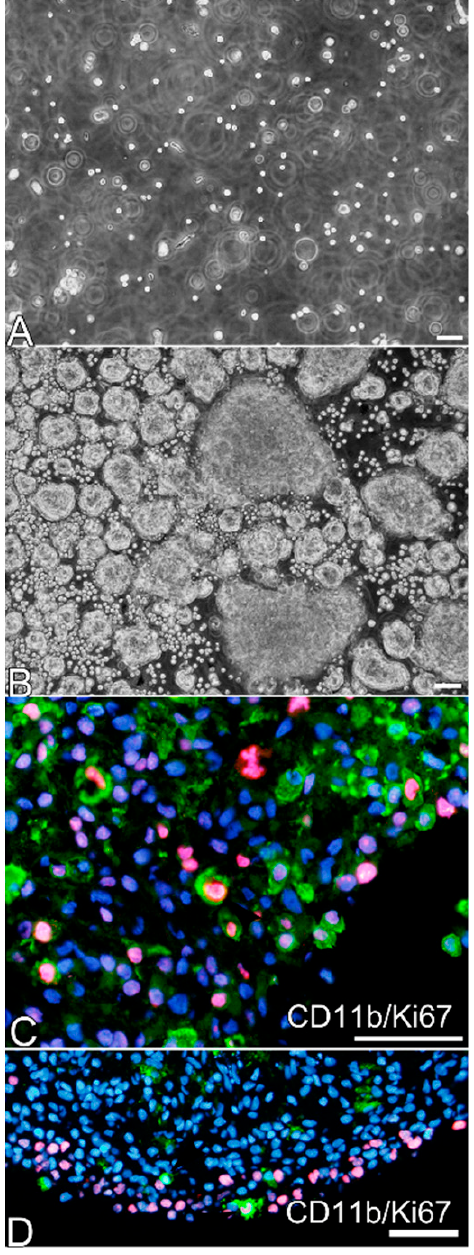
Figure 2. Dissociated and ex vivo cultures of peeled-off leptomeninges. ( A ) A phase contrast micrograph shows isolated cells suspended in E2-epidermal growth factor (EGF) that were obtained from peeled-off leptomeninges of neonatal rat brains by incubating with trypsin-ethylenediamine tetraacetic acid (EDTA). ( B ) After the dissociated cells were cultured for 4 days, they formed large aggregates. ( C ) After fixation, the aggregates shown in ( B ) were sectioned and immunostained with antibodies against CD11b (green), another marker of microglia/macrophages, and Ki67 (red). Many CD11b + amoeboid cells expressed Ki67 in the aggregates. Nuclei were stained blue by Hoechst 33258. ( D ) Sections of an ex vivo culture of leptomeninges maintained in E2-EGF for 6 days. There are also CD11b + (green)/Ki67 + (red) cells in an enlarged round piece of leptomeninges. Nuclei were stained blue by Hoechst 33258. Scale bar = 50 µ